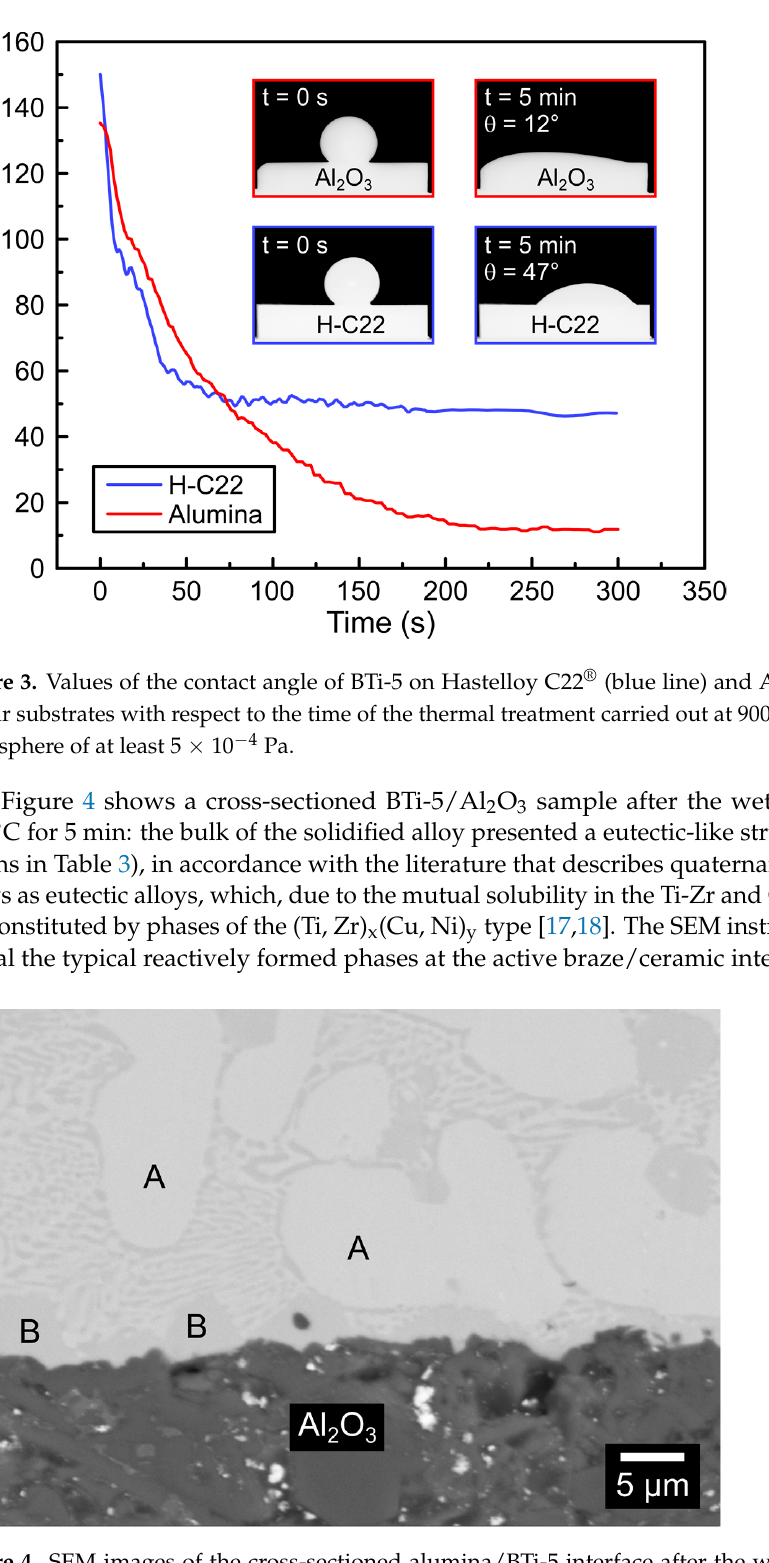
Figure 4. SEM images of the cross-sectioned alumina/BTi-5 interface after the wettability test at 900 °C for 5 min. Table 3. EDS analysis (at %) of the selected area of the alumina/BTi-5 sample (Figure 4).